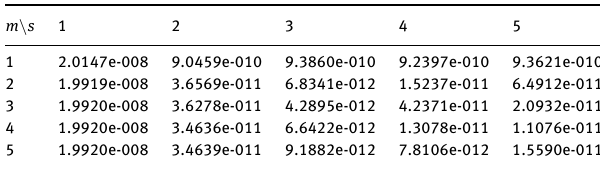
Table 7: Maximum errors E N for example 5 using N t = 5, m = s = 3 t \ N x